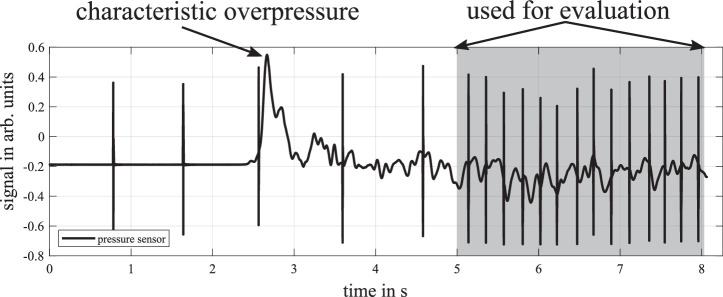
Course of raw pressure signal with characteristic touchdown behavior leading to overpressure at 2.8 seconds. The pre-evaluation phase from 0 to 5 seconds is not further evaluated. Starting from 5 seconds, the impulses were evaluated for IOP estimation (gray area). The pressure chamber was considered to be airtight.